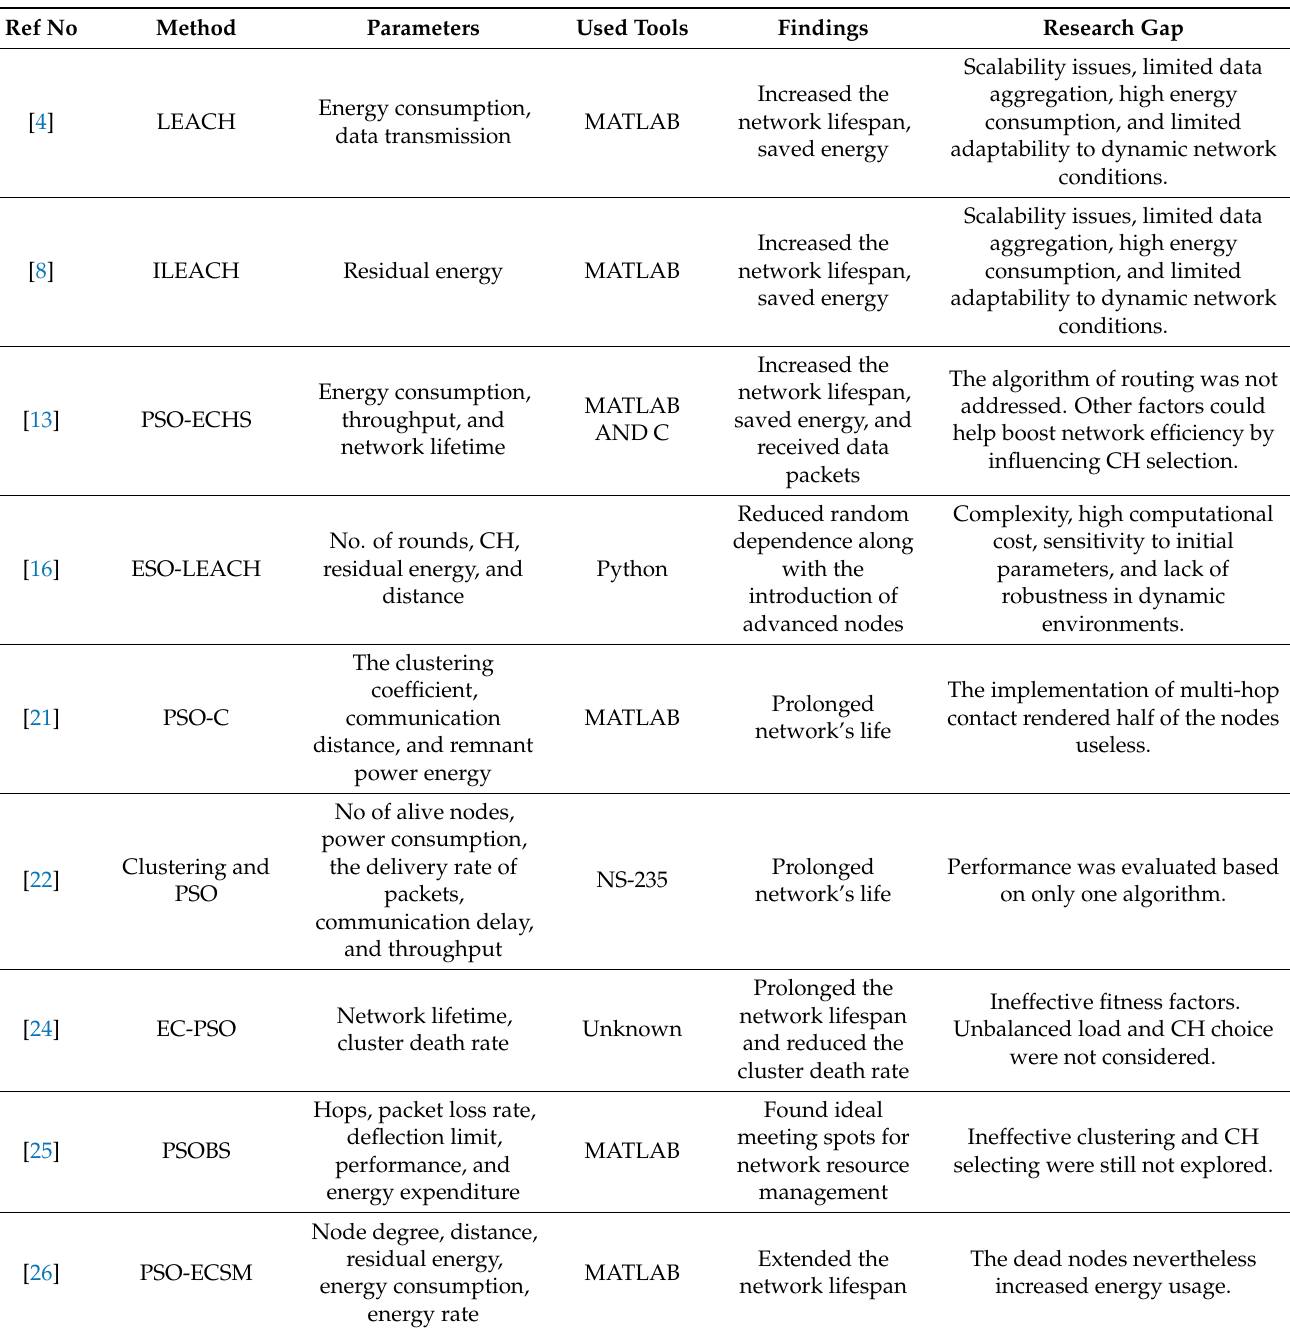
Table 2. Summary of existing